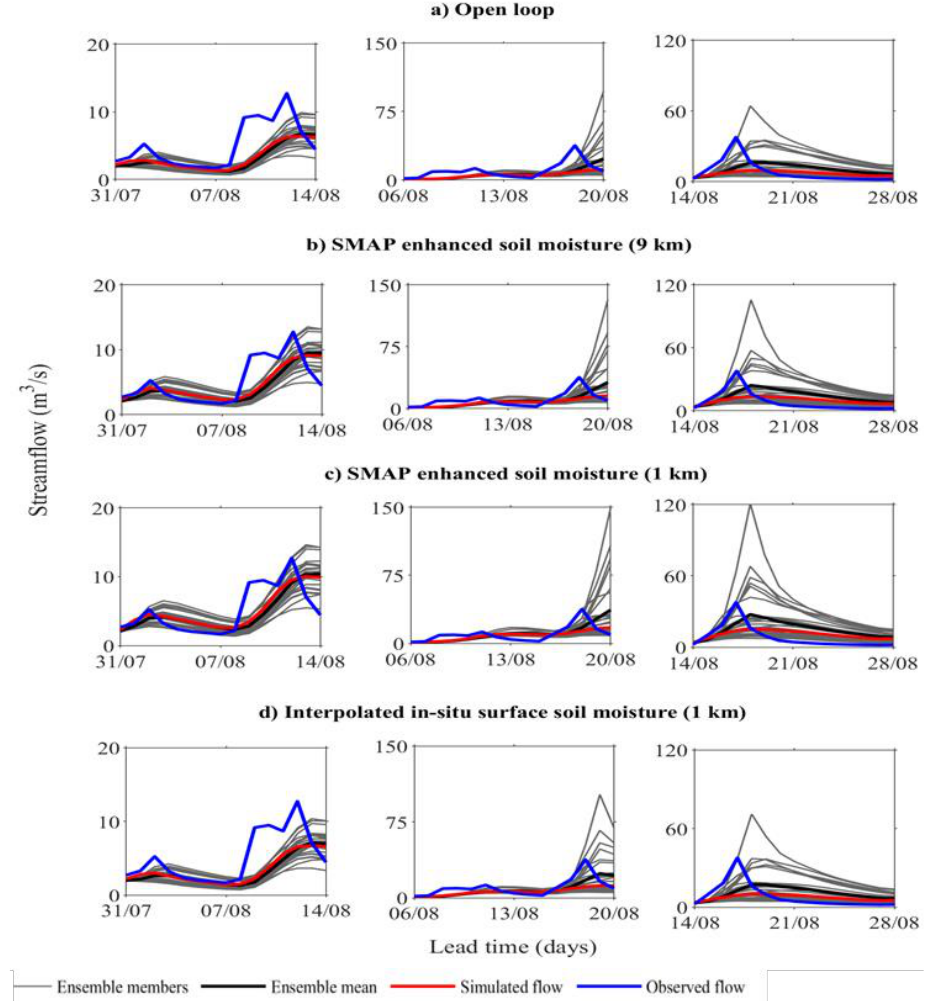
Figure 7. Ensemble streamflow forecast at the outlet au Saumon watershed: ( a ) without updating the model (open loop) and after updating with; ( b ) SMAP-enhanced (9 km); ( c ) downscaled SMAP- enhanced (1 km); ( d ) in-situ soil moisture.